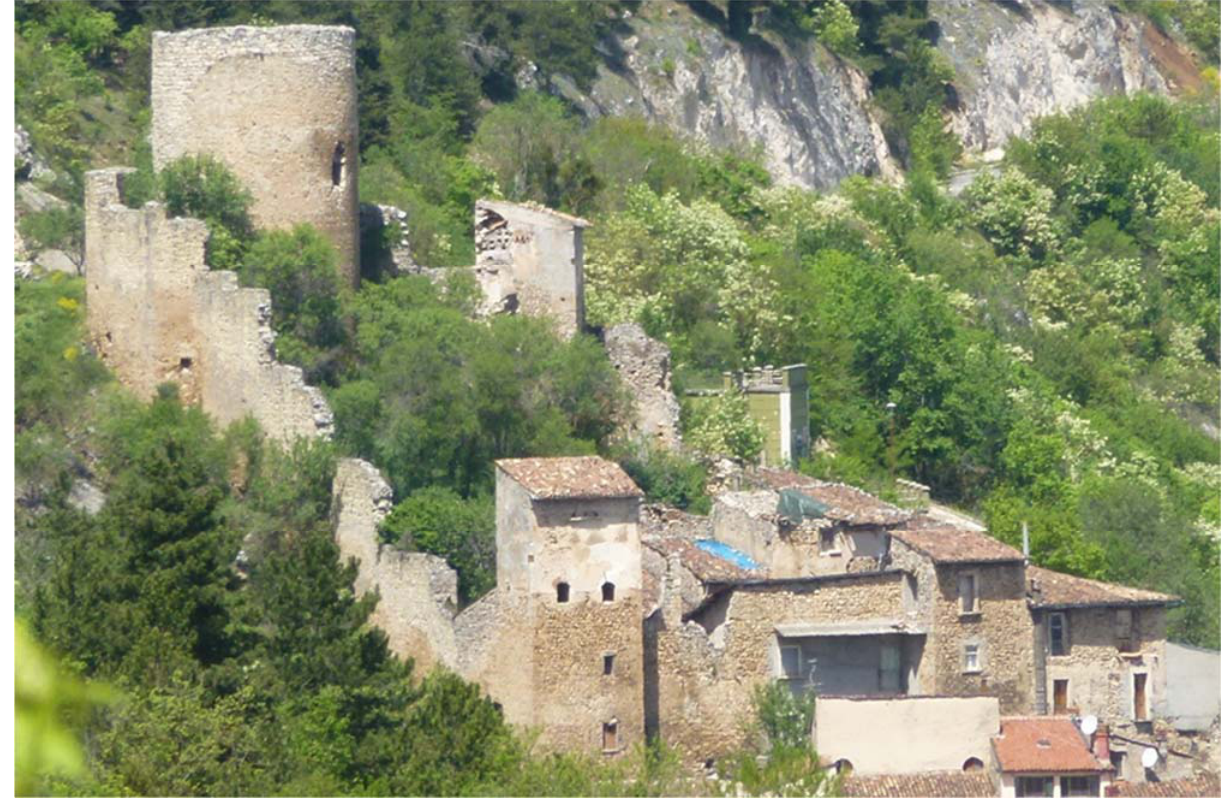
Figure 1: Panoramic view of the castle of